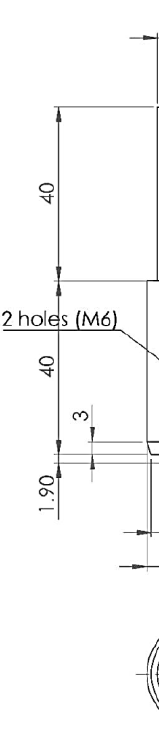
Table 2. For example, FM-3 represents the FSDC cladded sample with a rotation speed of 500 rpm and a traverse speed of 150 mm / min. During the FSDC process, the tool plunging depth and tool title angle ◦ were kept constant at 2 mm and 0 , respectively. As shown in the last column of Table 2, only five (5) out of the nine (9) cladded samples passed the interfacial shear tensile tests [4].